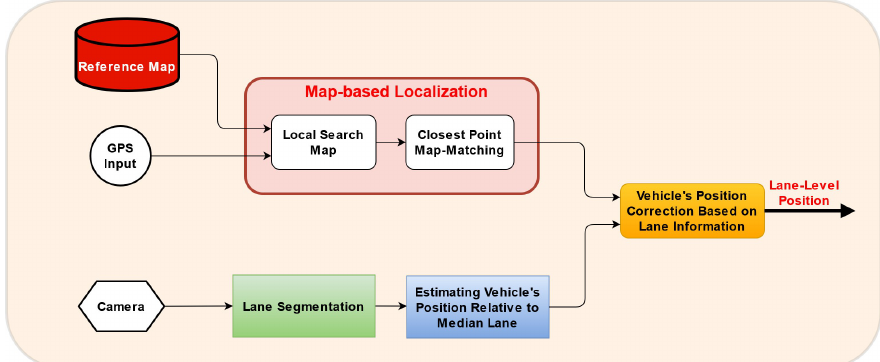
Figure 2. The pipeline of our proposed